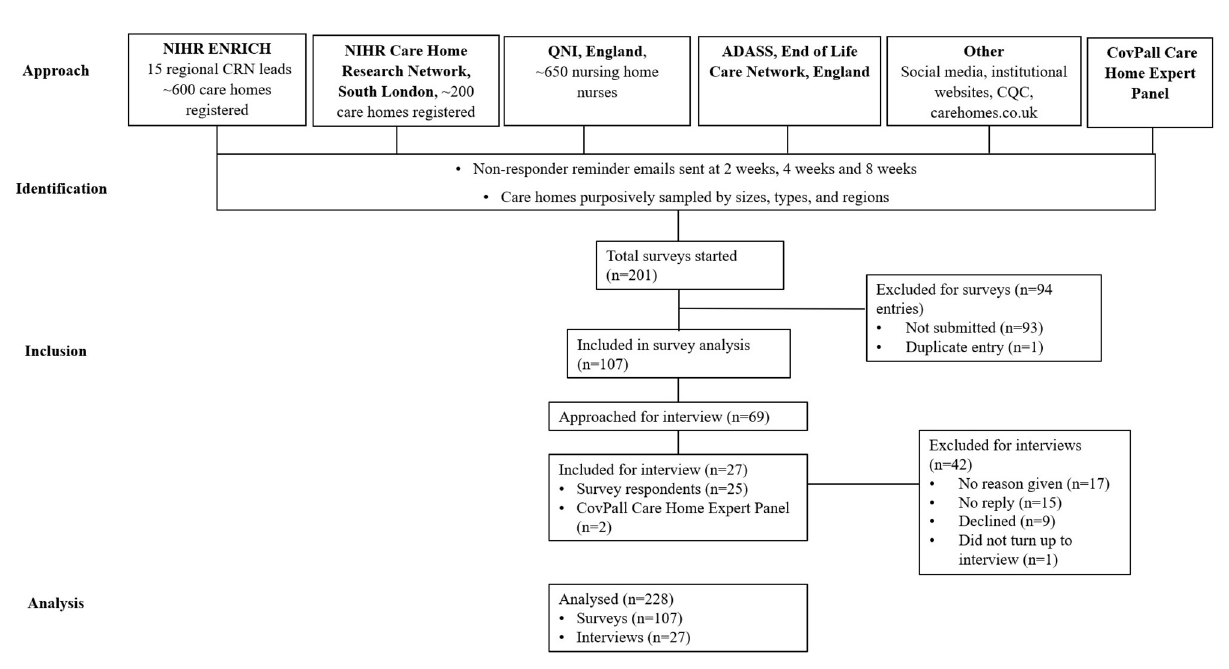
FIGURE1 Recruitment flow